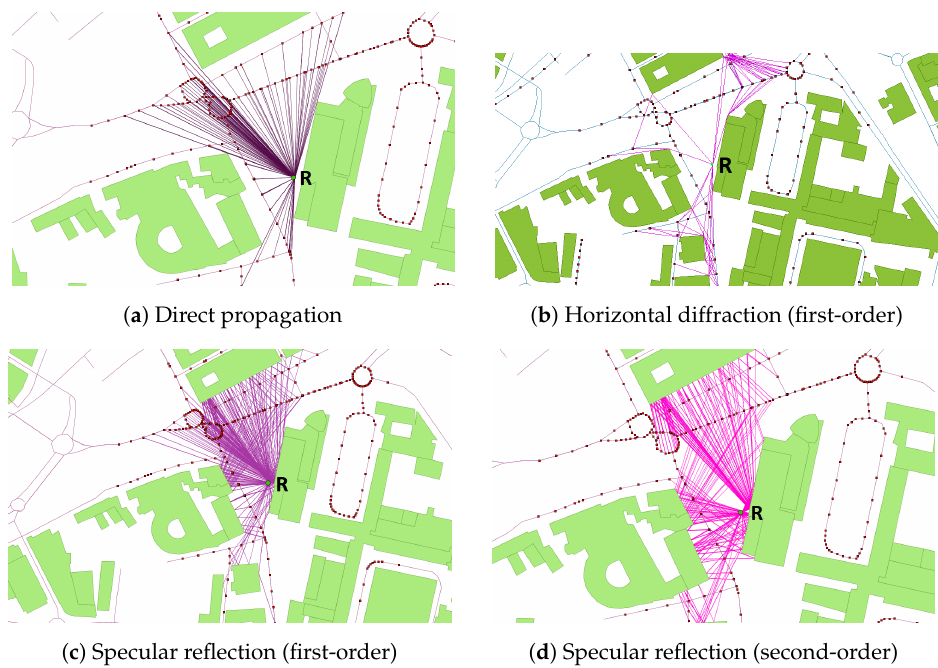
Figure 2. Illustrations of the propagation paths between the point sources (red) and a given receiver point (green) for each contribution to the total sound field: ( a ) direct path; ( b ) first-order horizontally diffracted path; and ( c , d ) first- and second-order specularly reflected